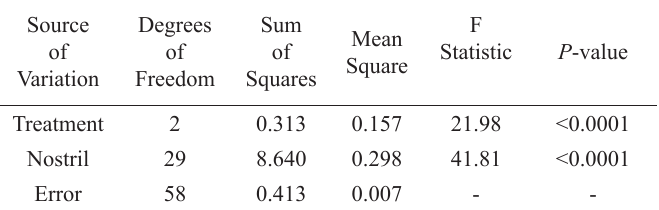
TABLE 1 – ANOVA. Area variable.